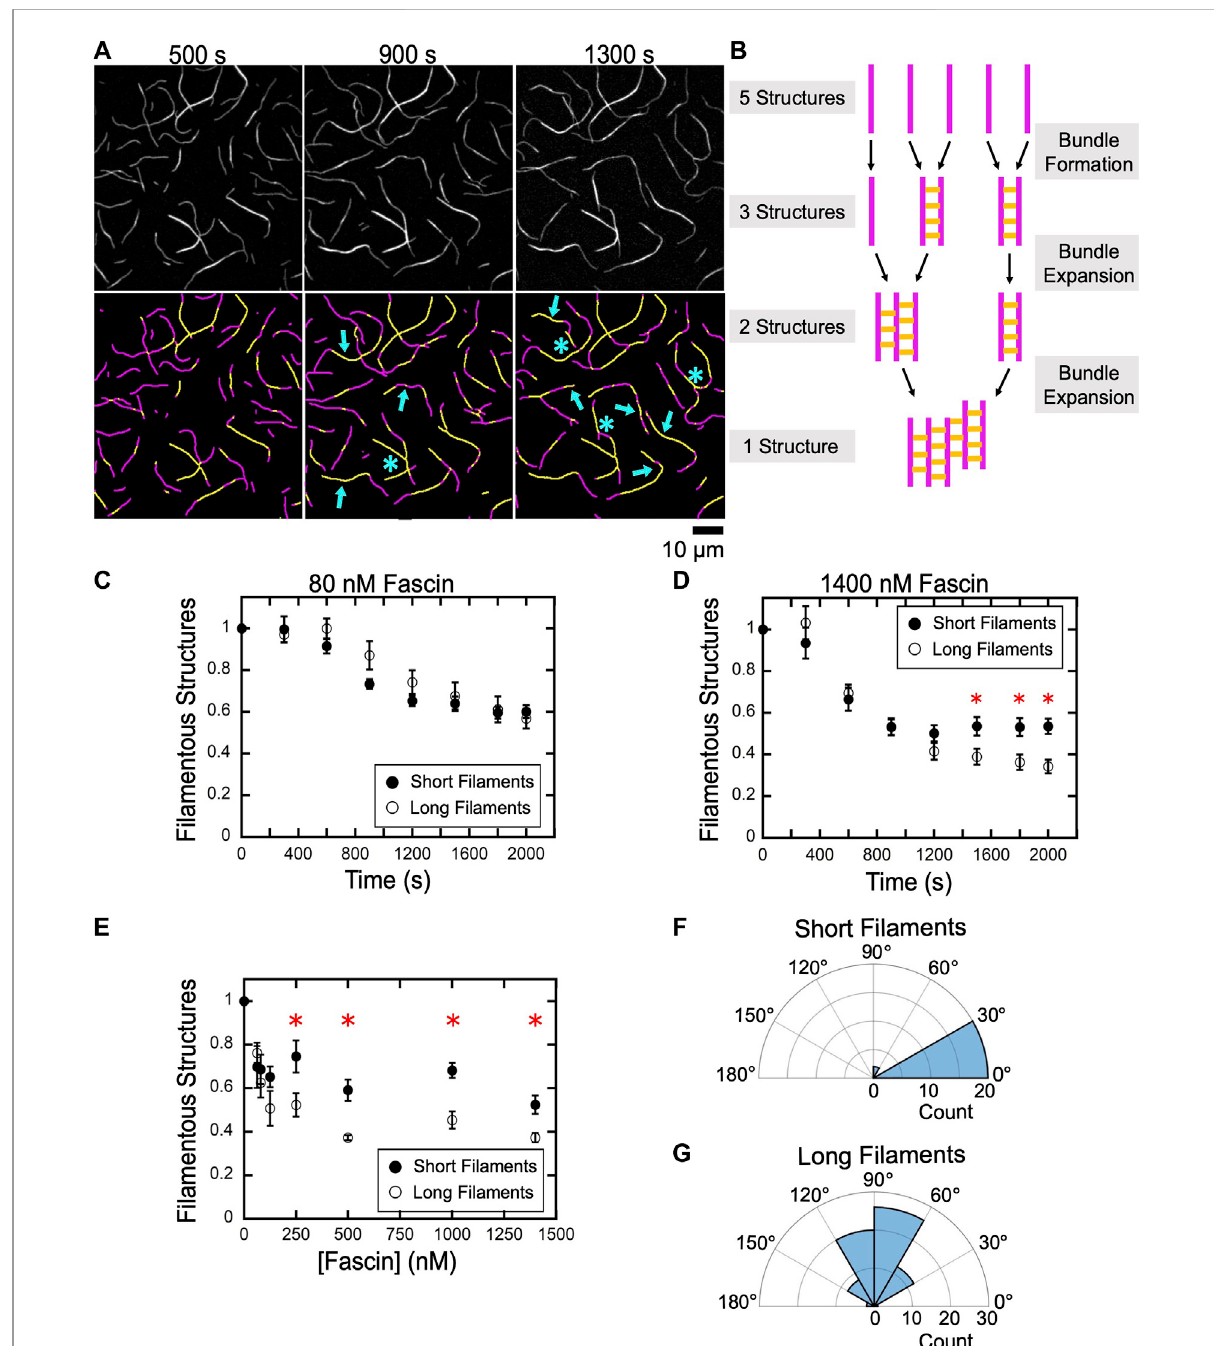
FIGURE 5 An increase in fi lament length promotes bundle expansion. Actin fi laments were labeled by FITC-phalloidin, bundled by a range of concentrations of fascin and imaged by TIRF microscopy. (A) Top row, TIRF Micrographs collected at 400 s intervals spanning the fi rst and second phases of a representative bundling reaction containing long fi laments and 1,400 nM fascin. Bottom row, Computationally-detected stretches of bundled (yellow) and single (magenta) fi laments. Blue arrows indicate regions where a pre-existing bundle has expanded by incorporating an additional fi lamentormergingwithanotherbundle.Blueasterisksindicatenonlinearbundlemorphologies. (B) Schematicillustratingtherelationship between bundle assembly progression and the number of fi lamentous structures contained in a bundling reaction. Filaments are depicted in magenta. Fascin-mediated crosslinks are shown in yellow. (C – E) The number of fi lamentous structures (i.e., the sum of the individual fi laments and bundles) visualized over time for reactions containing 80 nM (C) and 1,400 nM (D) fascin. The number of bundles was normalized to the number of fi laments present at the beginning of each reaction. Red asterisks indicate statistically signi fi cant differences ( p < 0.05 using Welch ’ s t -test) between measurements obtained for reactions containing short and long fi laments. Error bars are the standard error of the mean number of fi